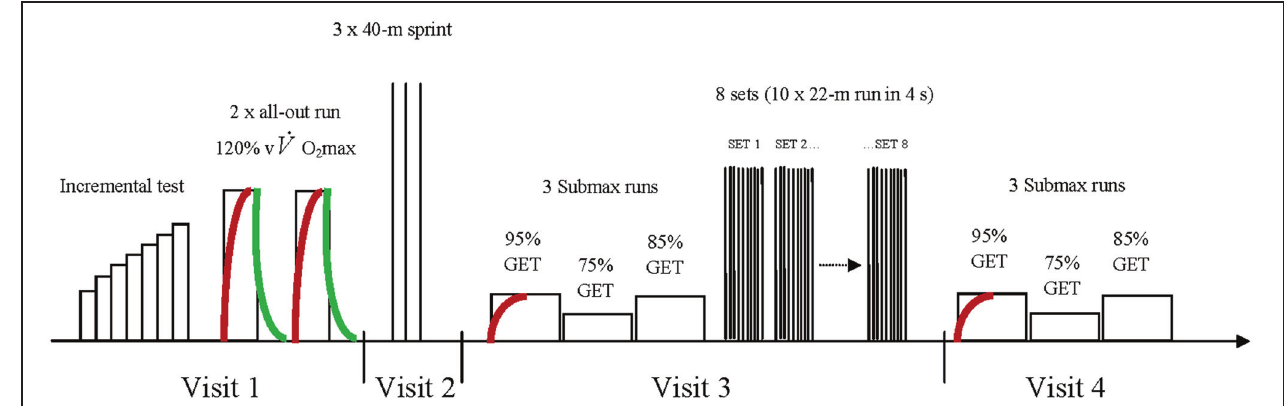
FIGURE 1 | Schematic representation of the protocol timing during the four visits. v ˙ V O 2 max, running speed associated with maximal oxygen uptake; GET, gas exchange threshold. The red and green curves